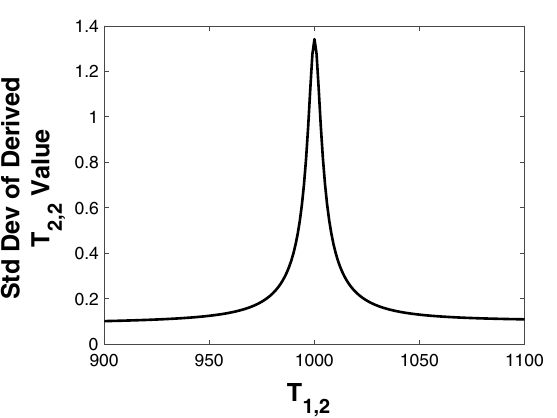
Figure 5. Results of analytical linearized calculation of SD for recovery of biexponential 2D model parameter T T 2,2 as a function of 1,2 , with other parameters fixed. Values are obtained from the square root of the diagonal elements of the covariance matrix defined by Eq.